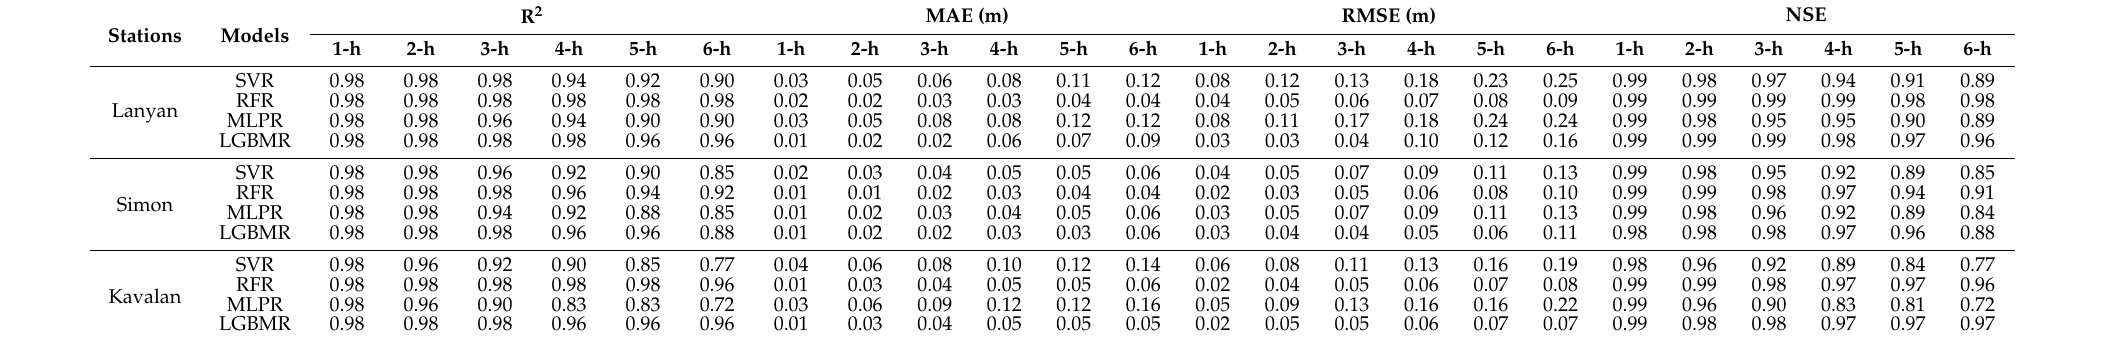
Table 7. The training results of four models for 1–6-h lead times at three